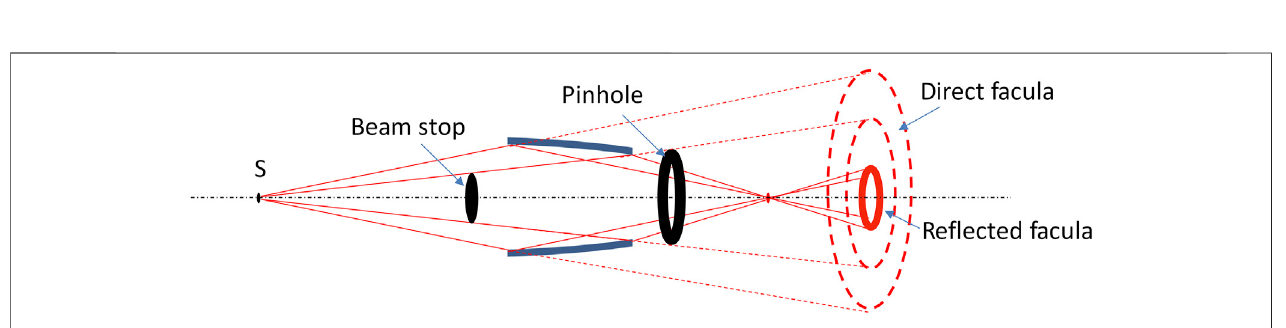
FIGURE 9 | Transmission ef fi ciency of the condenser by the beam stop and